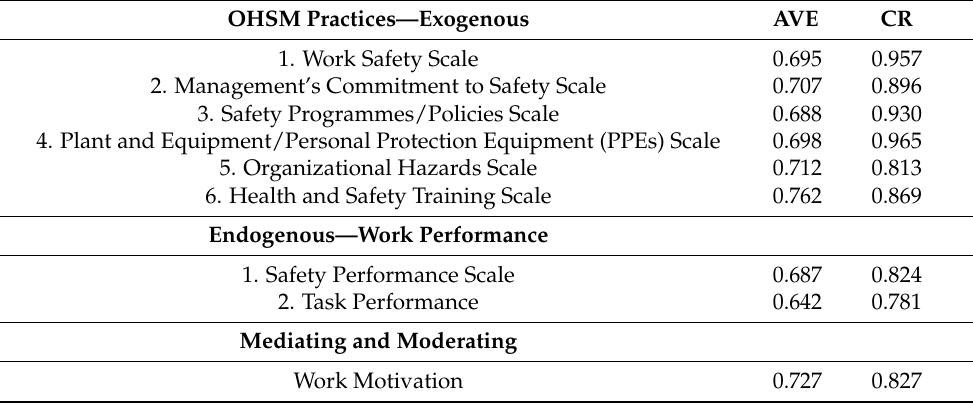
Table 5. Results of Convergence Validity of Scales.